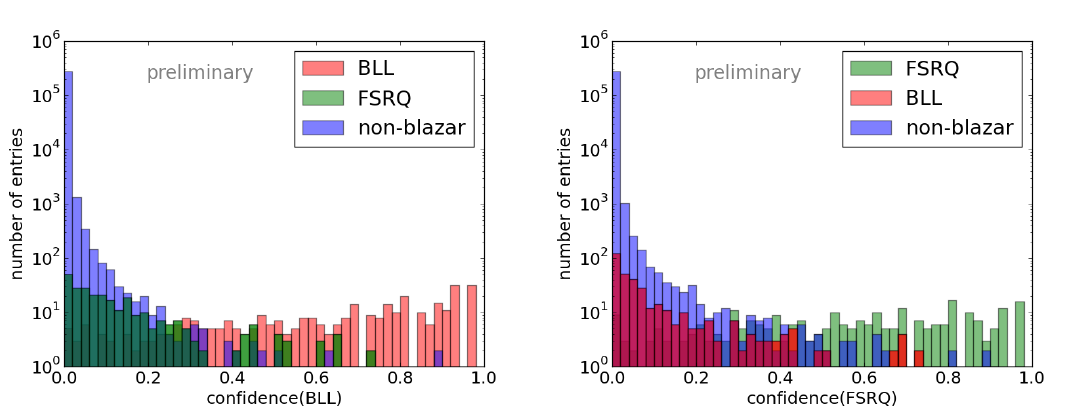
Figure 2. Confidence distribution for the BLL ( left ) and the FSRQ class ( right ). The classification model is applied to the training set extracted from the 3FGL and the ALLWISE catalog.